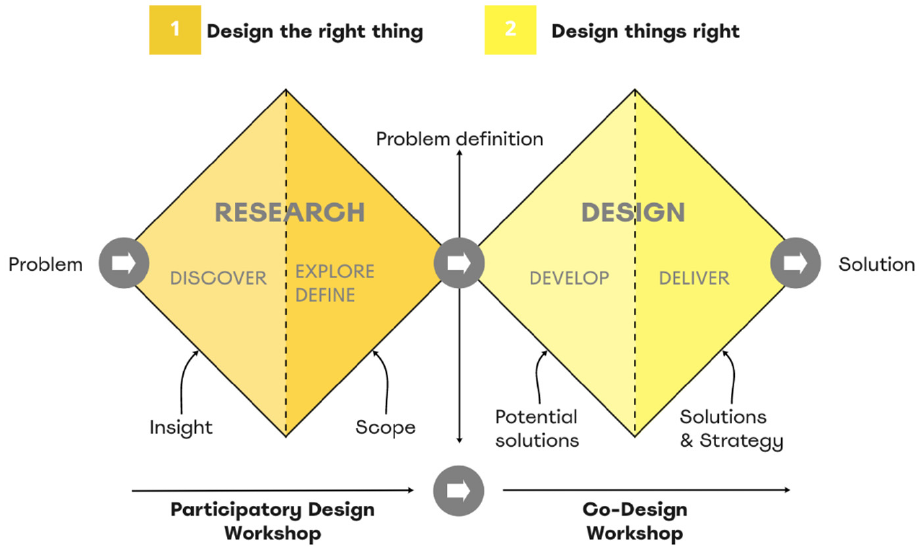
Figure 5. The double diamond approach, adapted from The Design Council [107], to fit the needs of this research.